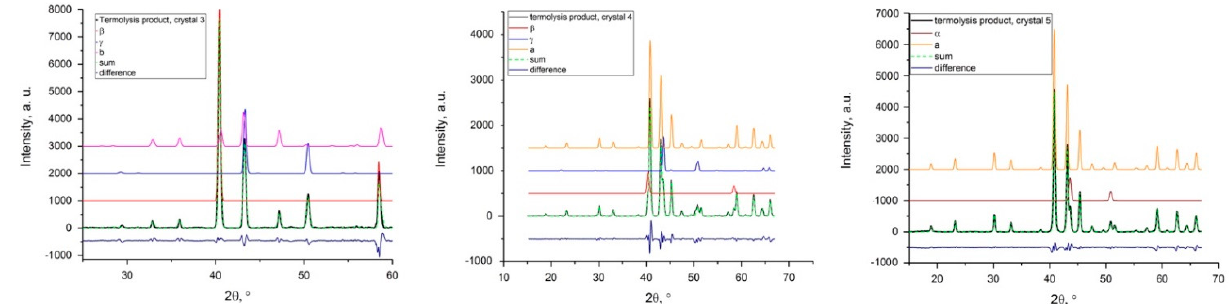
Figure 3. The results of the profile matching and cell parameters’ refinement diffraction pattern corresponding to the thermolysis of crystals № 3 ( left ), № 4 ( middle ), and № 5 ( right ) in H 2 (in-house single crystal diffractometer, MoK α− radiation, λ K α 1 = 0.70932 Å). Metallic products contain fcc − structured alloy ( α ), bcc − structured alloy ( β ), (Mo,W)Ni 4 ( γ ), Ni 2 (Mo,W) 3 N х (a), and Ni 6 (Mo,W) 6 C x (b) phases. Inserts show original 2D diffraction images used for the integration of the patterns.